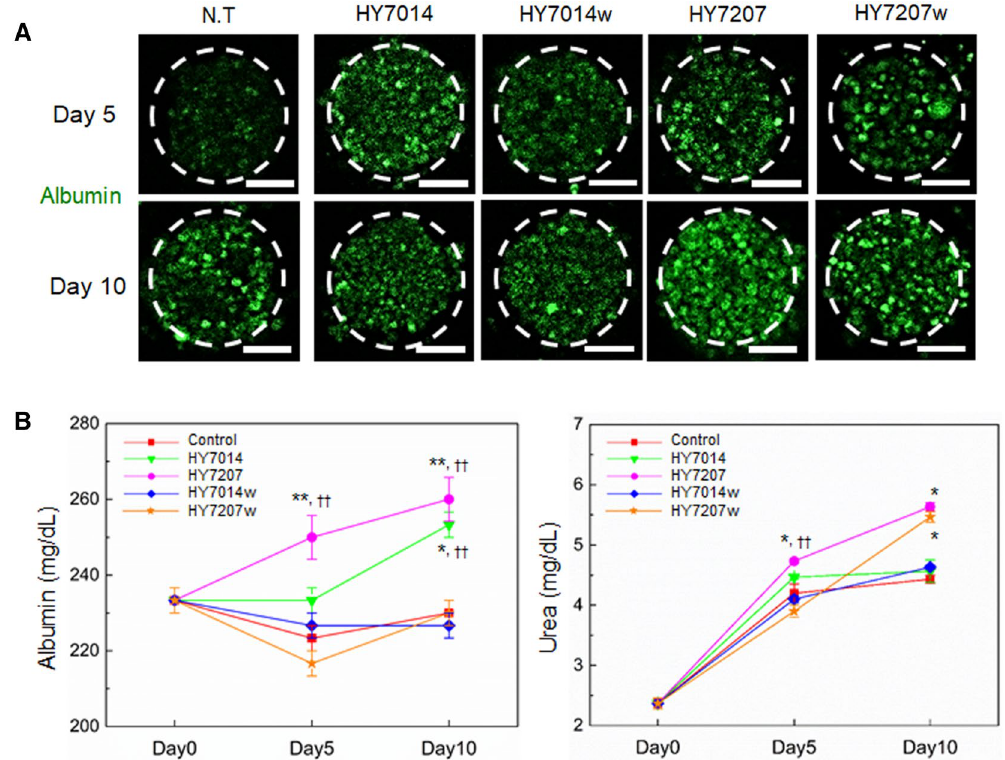
Fig. 5 A Immunostaining for serum albumin (green) in the microbial co‑cultured spheroids for 10 days. The nuclei were stained with DAPI (blue). Scale bars are 50 μm. B Analysis of the function of microbial co‑cultured spheroids, measuring in terms of the secretion of albumin (left) and urea (right). Data are represented as the mean standard error (SEM) of three independent experiments. * p < 0.05 for control vs. each group, ** p < 0.01 ± for control vs. each group, and †† p < 0.01 for wild type vs. each experimental